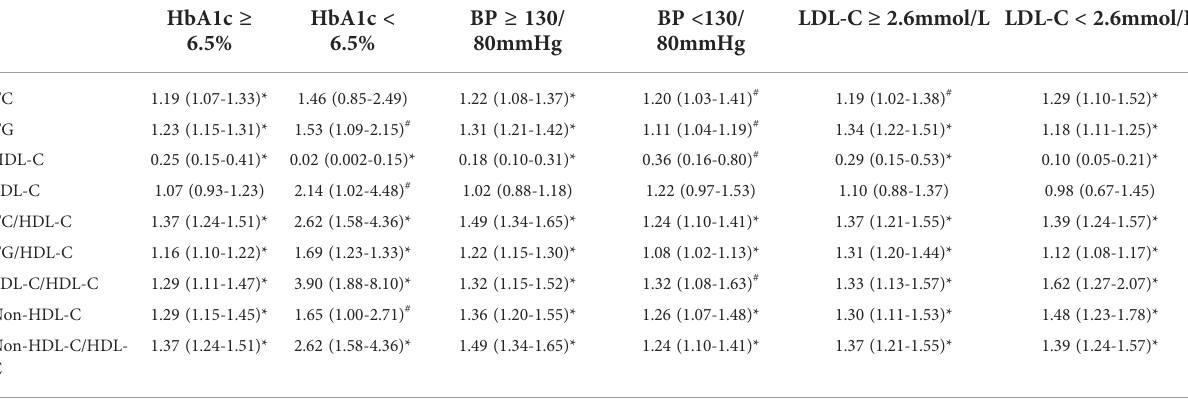
TABLE 4 Odds ratios 95% con fi dence intervals of lipid parameters for non-alcoholic fatty liver disease according to metabolic goal attainment status. HbA1c ≥